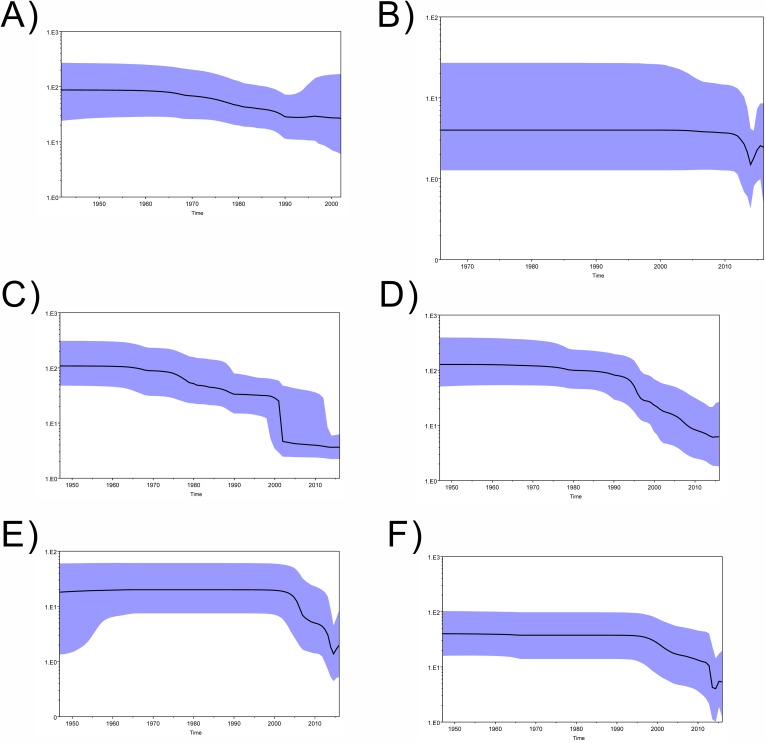
Zika virus (ZIKV) population dynamics of genetic diversity over time.The effective estimated population size of virus is shown on y-axis. X-axis shows the time before 2016. The colored area corresponds to the credibility interval based on 95% highest HPD. Mean and median values for relative genetic diversity (y-axis) together with credibility intervals were plotted through time (x-axis). (A) NS5 by African lineage (B) NS5 by South Pacific Rim lineage (C) NS5 (D) ENV (E) NS1 (F) NS3.